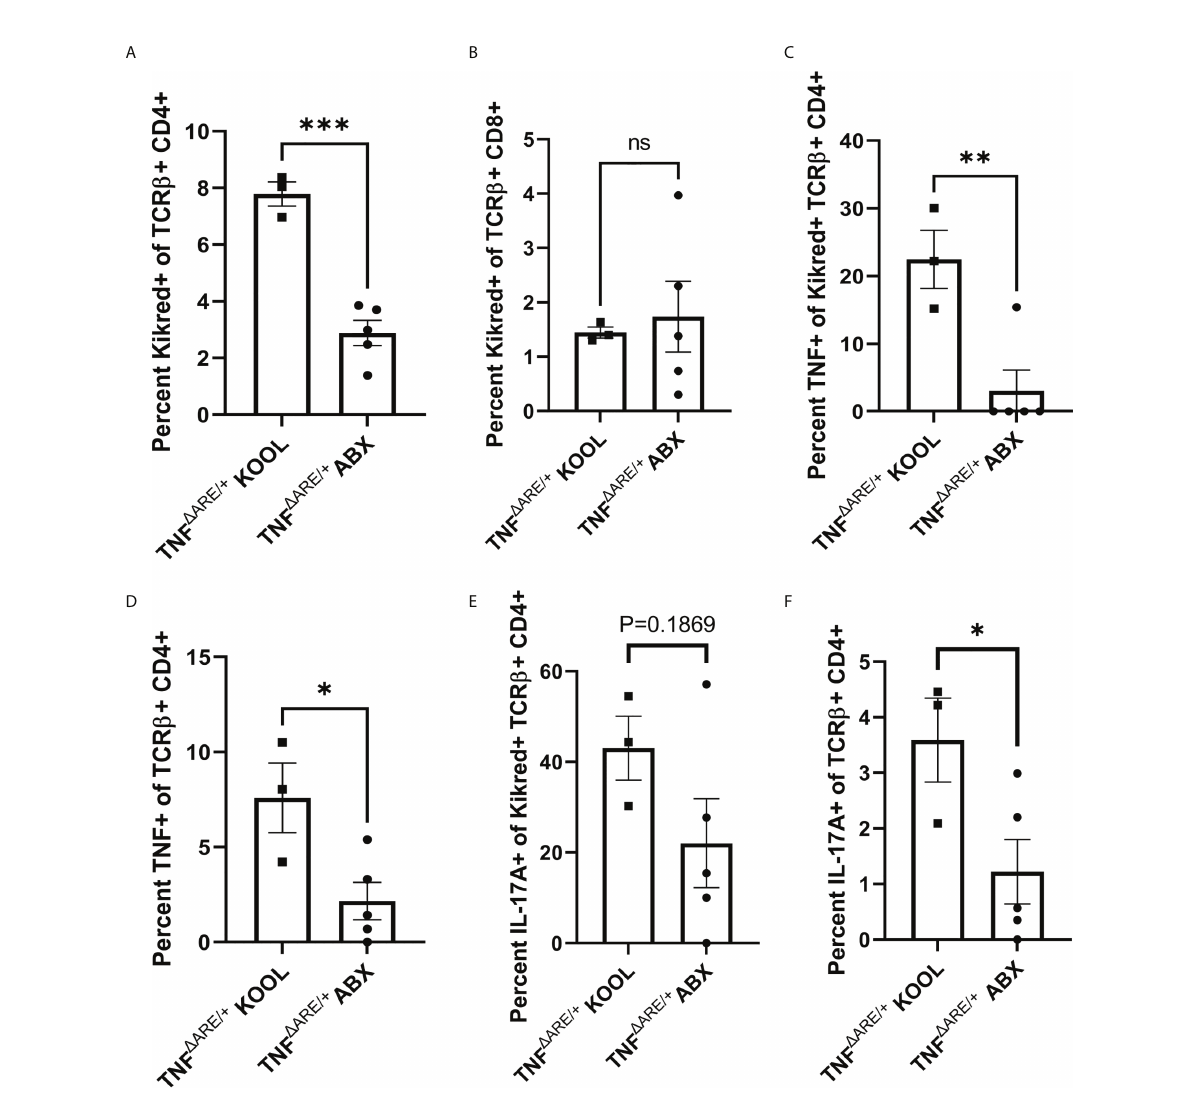
FIGURE 6 Treating TNF D ARE/+ mice with antibiotics reduces gut-joint traf fi cking and cytokine competence in CD4+ T cells. Male and female KikGR+ TNF D ARE/+ mice were given either broad spectrum antibiotics, consisting of ampicillin, neomycin, metronidazole, and vancomycin in 10% grape Kool-Aid (n=5) or Kool-Aid alone as vehicle control (n=3) ad libitum in the drinking water from 4-16 weeks of age. At 16 weeks old the mice underwent photoconversion of the distal colon and the PLNs harvested 72 hours later. T cells were puri fi ed by magnetic negative selection and stimulated with bead-bound anti-CD3 and anti-CD28 in the presence of protein transport inhibitor for 4 hours. (A) The percentage of KikRed+ cells within the TCR ab + CD4+ population and (B) TCR ab + CD8+ population was assessed by fl ow cytometry. The percentage of TNF+ cells within the KikRed+ TCR ab + CD4+ population (C) as well as the global TCR ab + CD4+ (D) was determined by fl ow cytometry. The percentage of IL-17A+ cells within the KikRed+ TCR ab + CD4+ population (E) as well as the global TCR ab + CD4+ (F) was also determined by fl ow cytometry. Data are shown as individual animals with bars as mean ± SEM. *P<0.05; **P<0.01; ***P<0.001; as determined by Student ’ s T